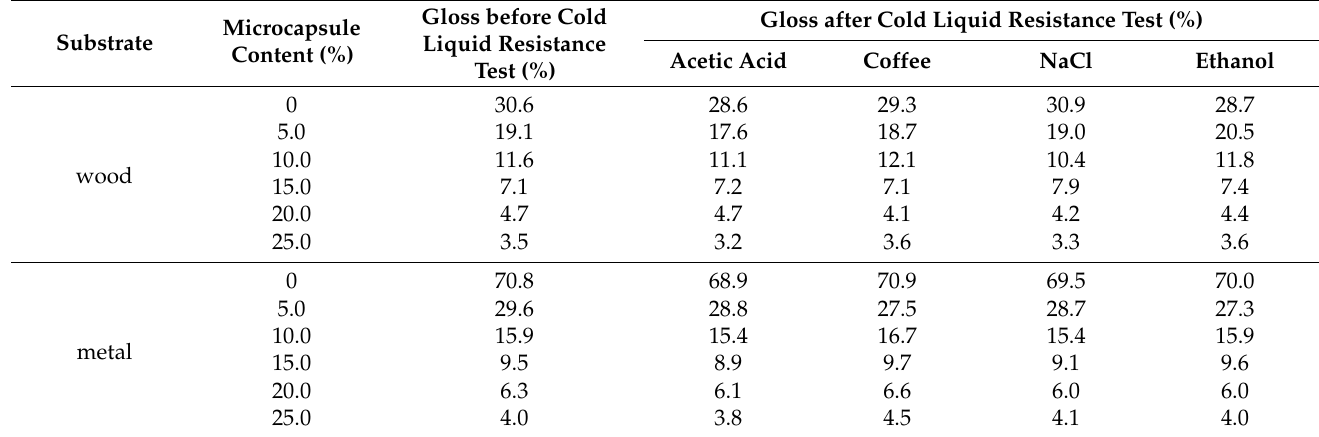
Table 11. Gloss of the coatings before and after cold liquid resistance test.